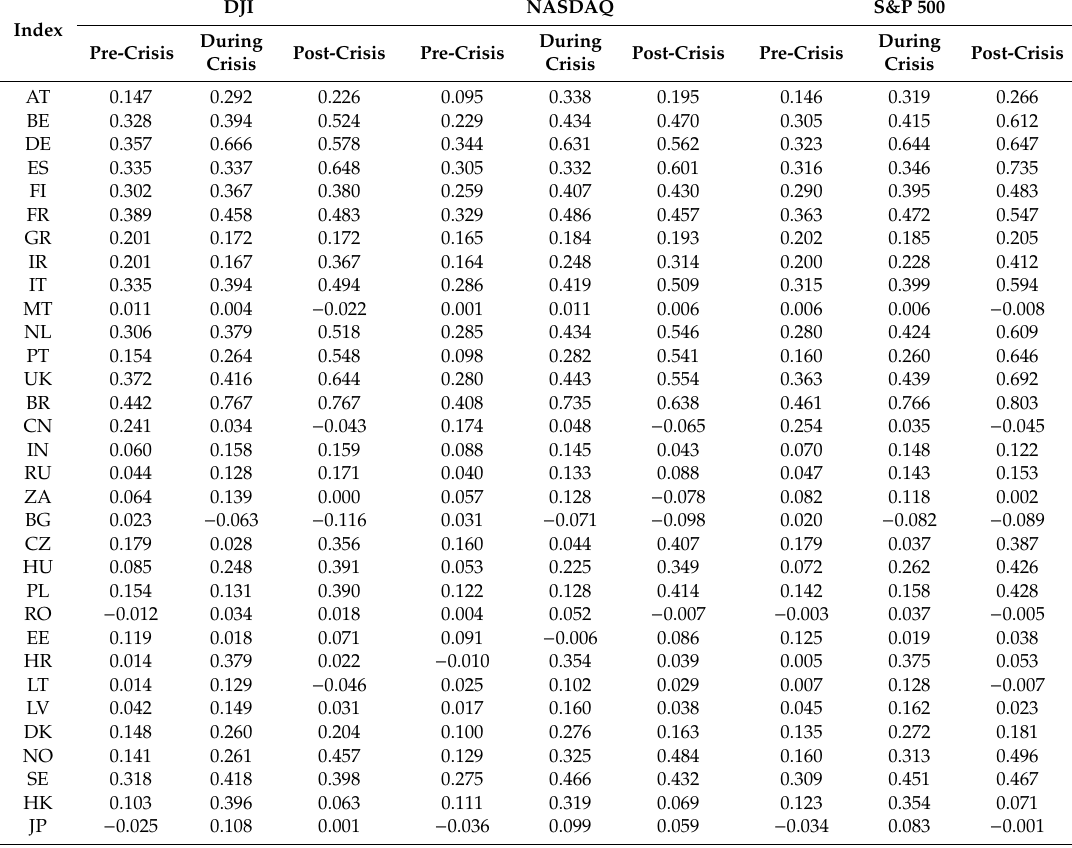
TableA2. Crosscorrelationscoe ffi